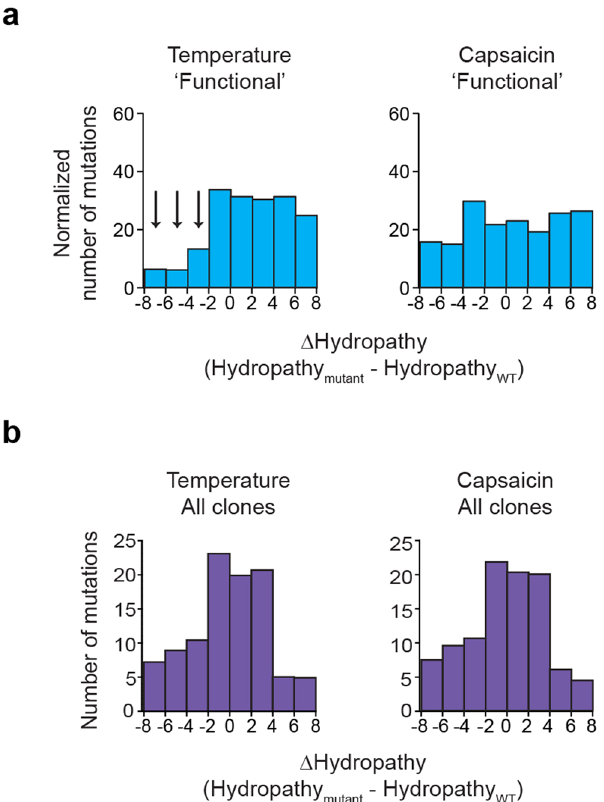
Figure 4. Hydropathy changes induced by mutations. ( a ) Histograms showing the change in hydropathy (hydropathy mutant − hydropathy WT ) for mutations in ‘functional’ clones screened with temperature or capsaicin. Data is normalized so that the sum of a bin from the ‘functional’ group and the respective bin from the ‘less functional’ group is equal to 100%. ( b ) Change in hydropathy for all 1,110 temperature- and 1,145 capsaicin- characterized